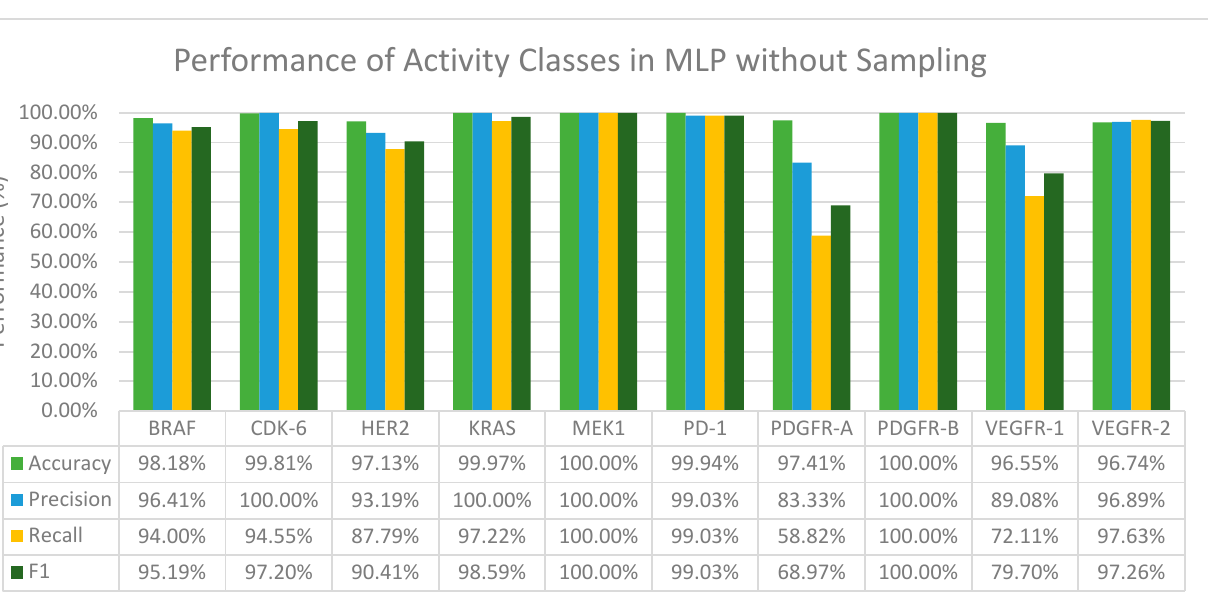
Figure 3. The performance of MLP in terms of accuracy, precision, recall and F1 score without sam- pling.